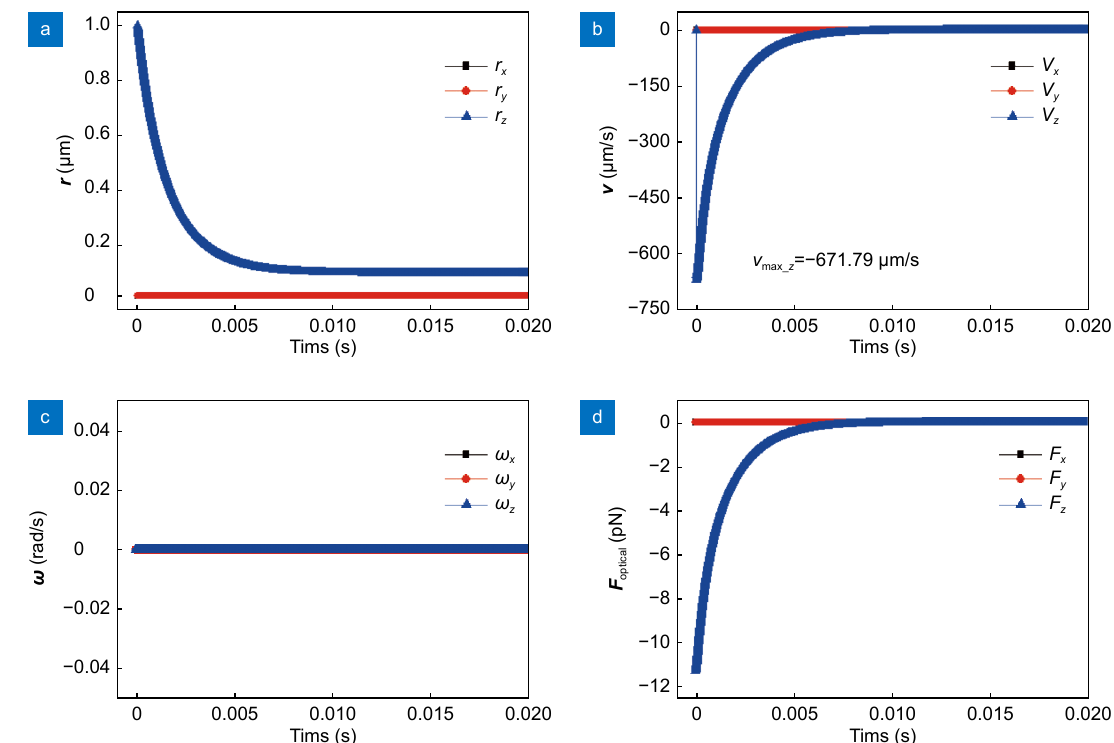
Fig. 2 | The dynamic process of the micro-sphere in an optical tweezers. Plots of the ( a ) position, ( b ) velocity, ( c ) angular velocity, and ( d ) optical force versus time under the initial condition of r 0 =[0,0,1] μm, v 0 =[0,0,0] μm/s, ϕ 0 =[0,0,0] rad, and ω 0 =[0,0,0]